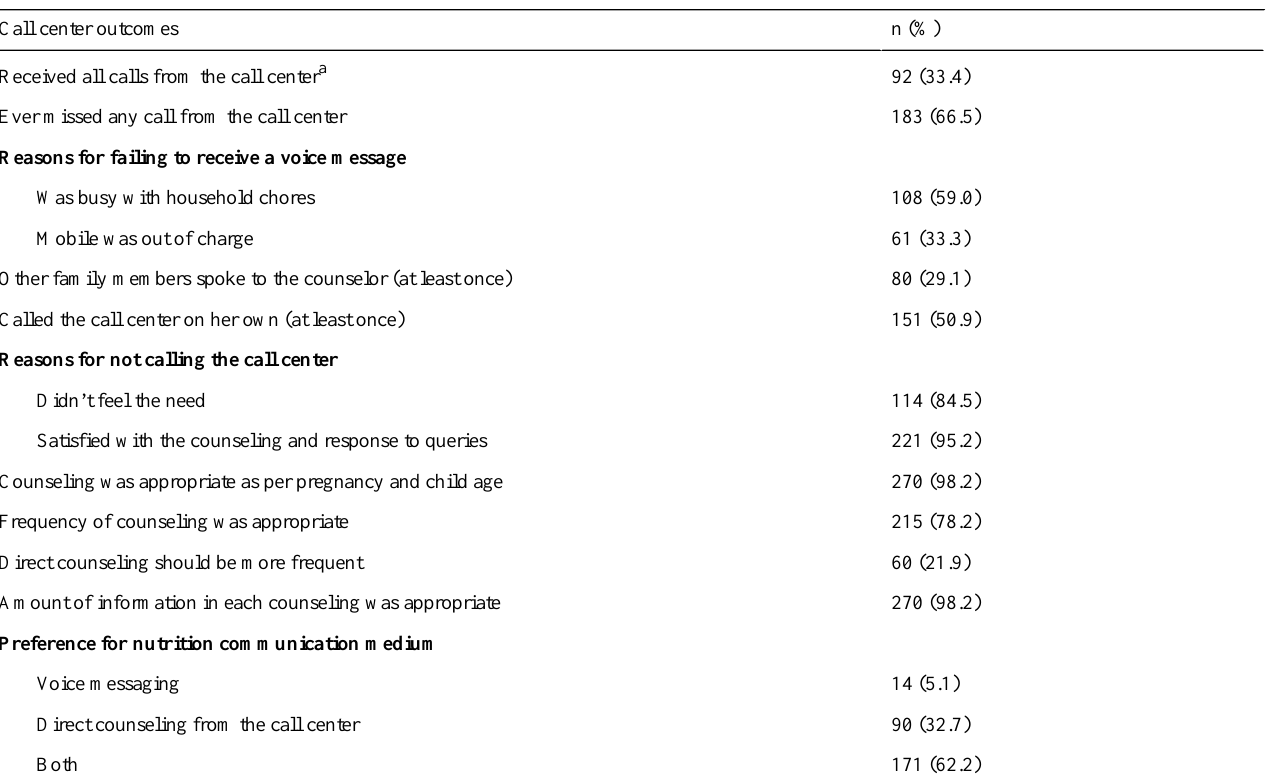
Table 5. Feasibility and perceived appropriateness of direct nutrition counseling through mobile phone